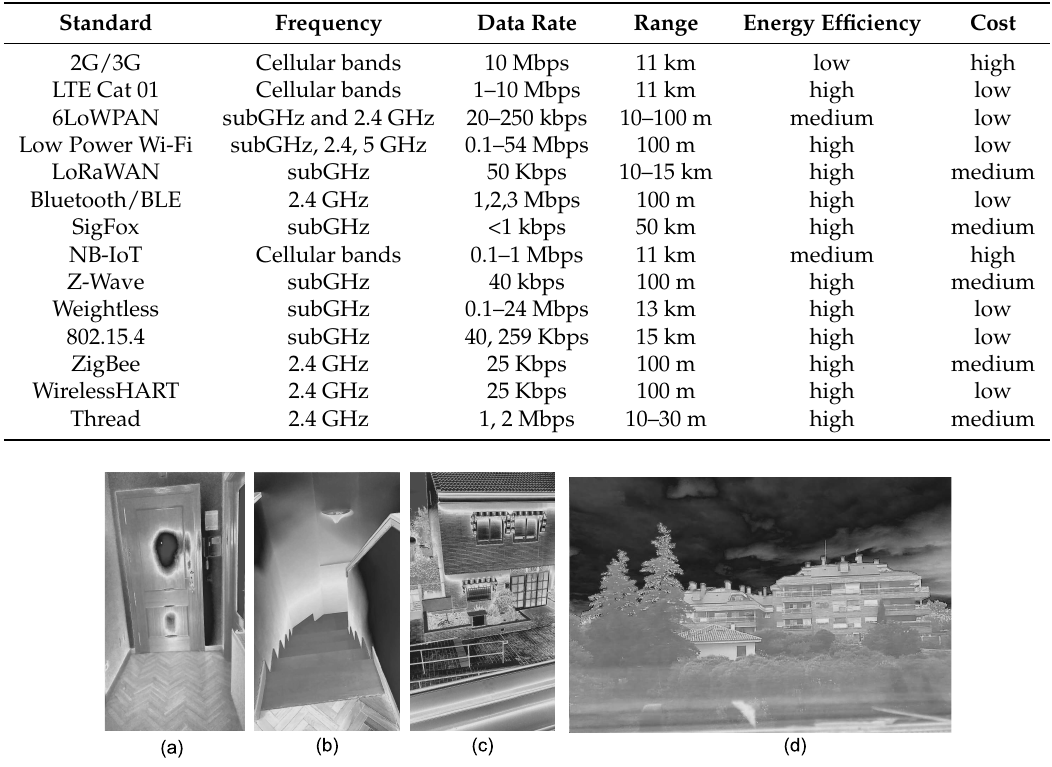
Figure 3. Thermographic pictures: ( a ) main entrance door; ( b ) stairs connecting ground and first levels; ( c ) main entrance wall; ( d ) surrounding